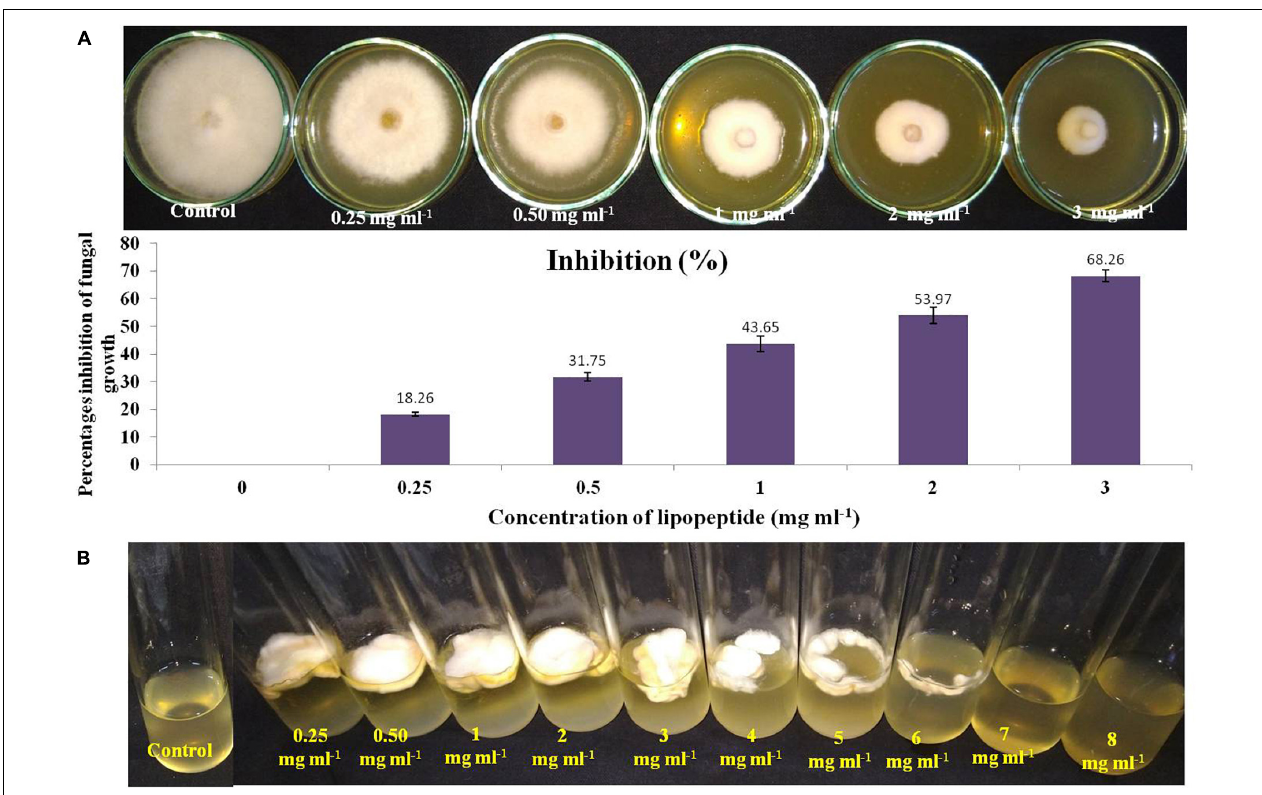
FIGURE 5 | Measurement of minimum inhibitory concentration (MIC) of lipopeptide against Fusarium sp. (A) . Effects of different concentration of lipopeptides on PDA plate (A-first lane) and their percentages inhibition (A-second lane), (B) . Effects of different concentration of lipopeptides in PDB, (Control A- without lipopeptide, Control B- without lipopeptide and